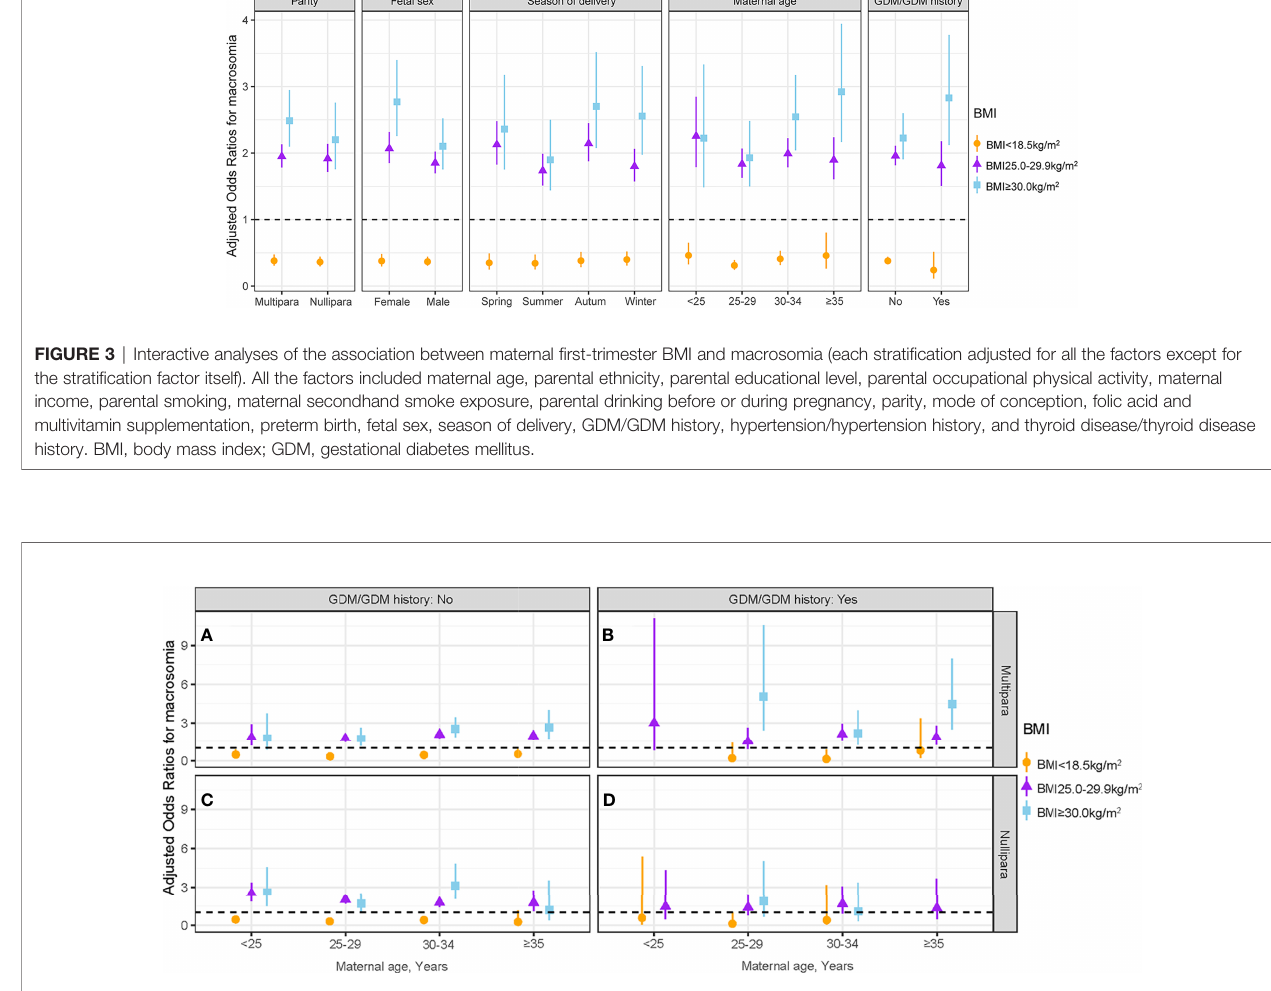
FIGURE 4 | Association between maternal fi rst-trimester BMI and macrosomia strati fi ed by GDM/GDM history status, parity, and maternal age. The association between maternal fi rst-trimester BMI and macrosomia in multipara without GDM/GDM history (A) , multipara with GDM/GDM history (B) , nullipara without GDM/GDM history (C) and nullipara with GDM/GDM history (D) . BMI, body mass index; GDM, gestational diabetes